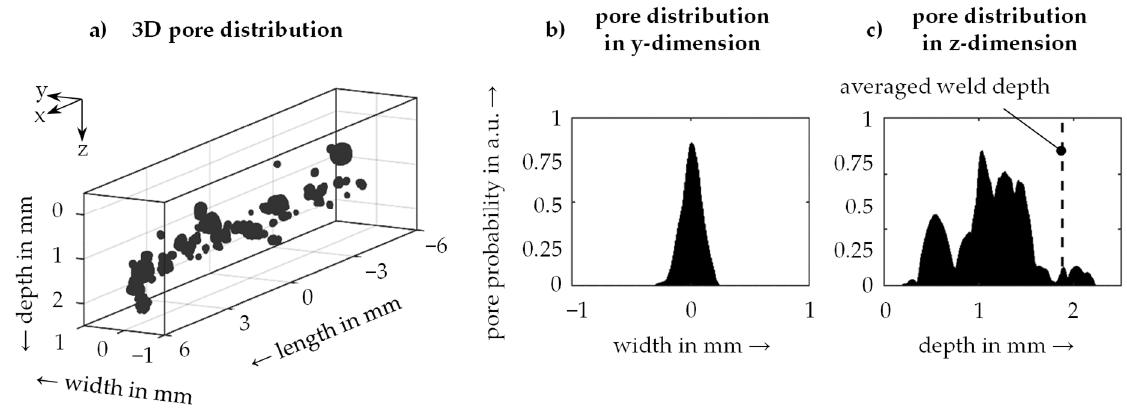
Figure 7. Characterization of porosity based on 3D measurements: ( a ) 3D distribution of process pores, ( b ) distribution of pores over the width and ( c ) over the depth of a representative weld seam; material AA 2219, laser power 1.5 kW, feed rate 9 m/min.